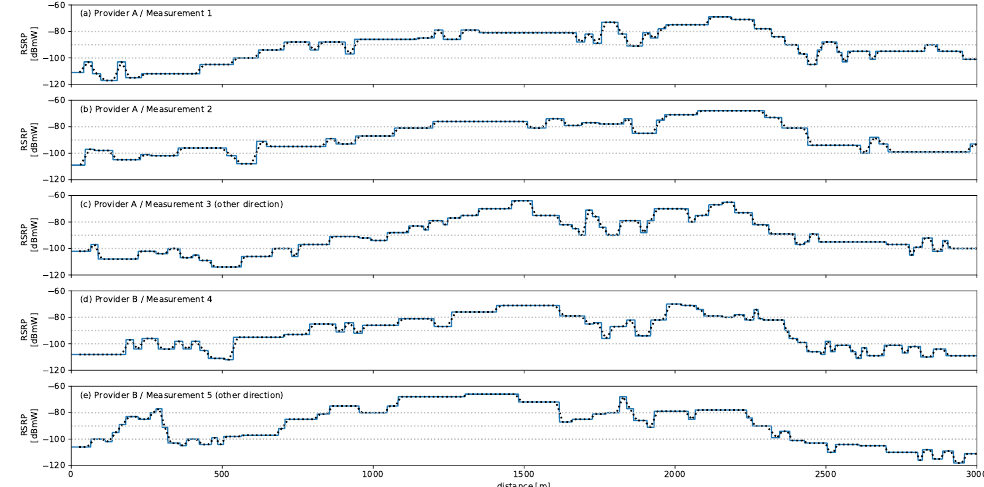
Figure 6. RSRP as a function of distance based on five independent measurements (solid lines: raw data; dots: resampled, interpolated data). Gray, dotted horizontal lines indicate ranges according to Table 4.